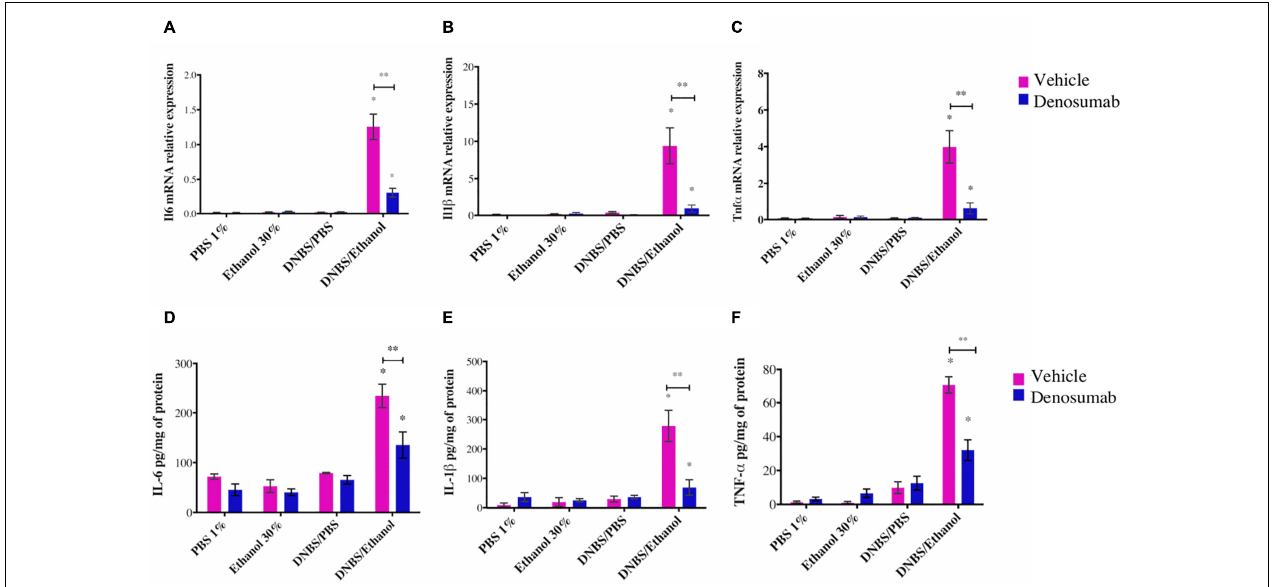
FIGURE 5 | The effects of DNBS/Ethanol-induced colitis and denosumab treatment on the colonic IL1 β , IL-6, and TNF- α pro-inflammatory cytokines. DNBS/Ethanol increased ( p < 0.05) colonic pro-inflammatory cytokines (A–C) . The cytokine expression levels were confirmed using qRT-PCR analysis (D–F) . TATA Box Binding Protein (TBP) is used as housekeeping genes for qRT-PCR. Error bars are shown as SEM. ∗ p < 0.001 when compared with other induction models within the denosumab or vehicle group, and ∗∗ p < 0.001 when compared one induction model within the denosumab and vehicle group. calculated using SAS MIXED procedure and illustrated by Prism using two-way ANOVA. n = 6 mice per